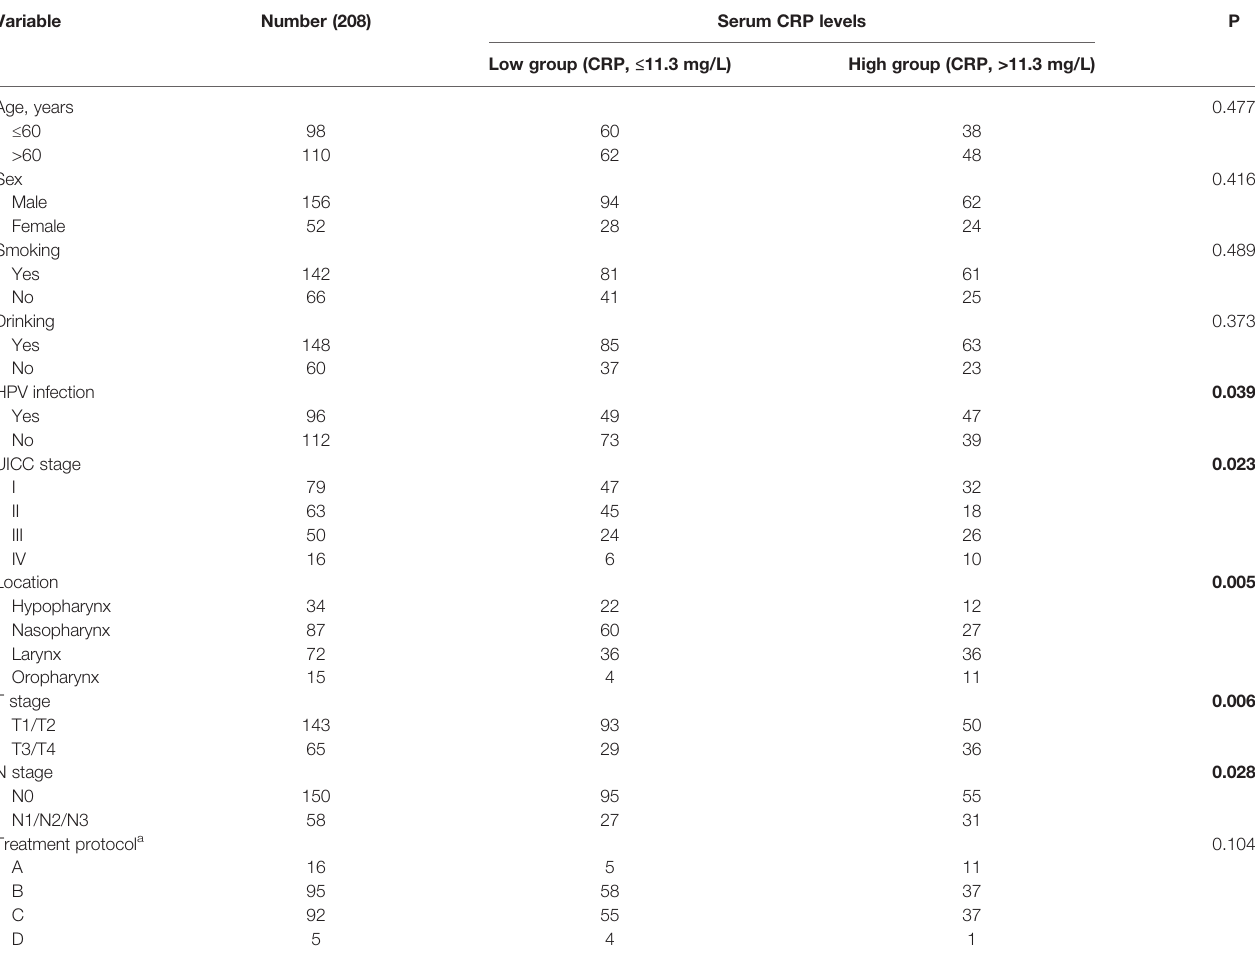
TABLE 1 | Patients ’ characteristics of